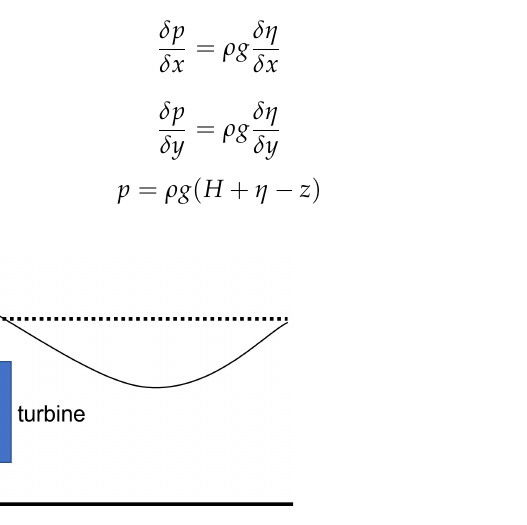
Figure 4. Qualitative representation of the free surface displacement across the turbine. H is the water column undisturbed depth; the free surface displacement is emphasized for explanatory